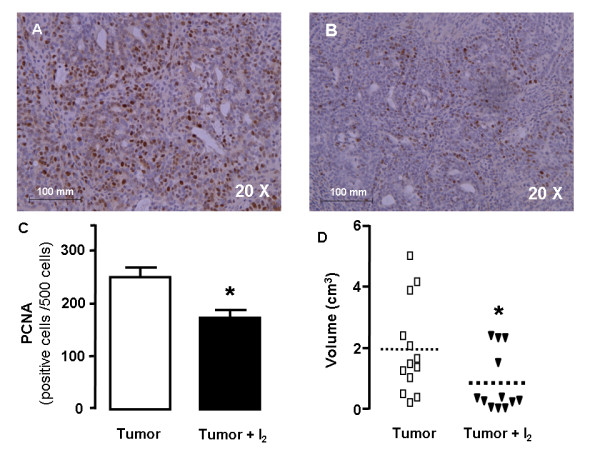
Proliferative rate. Immunohistochemical presence of PCNA-positive cells in tumors from control (A) and I2-supplemented rats (B); PCNA-positive cells were revealed with diaminobenzidine (brown stain) and counterstained with hematoxylin (purple stain). C, quantification; D, size of tumors (Volume). Differences between experimental groups were analyzed using an unpaired t test. *indicates significant difference from the appropriate control (p < 0.05).